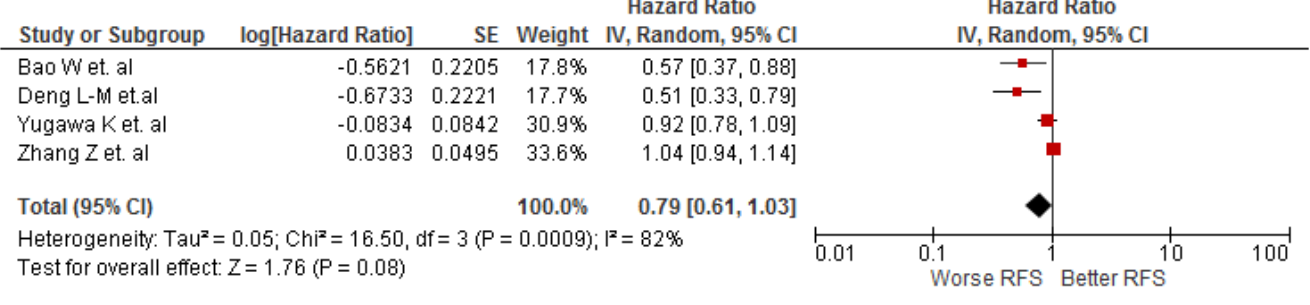
8 of 13 Figure 3. Association of LMR and DFS in patients with cholangiocarcinoma.